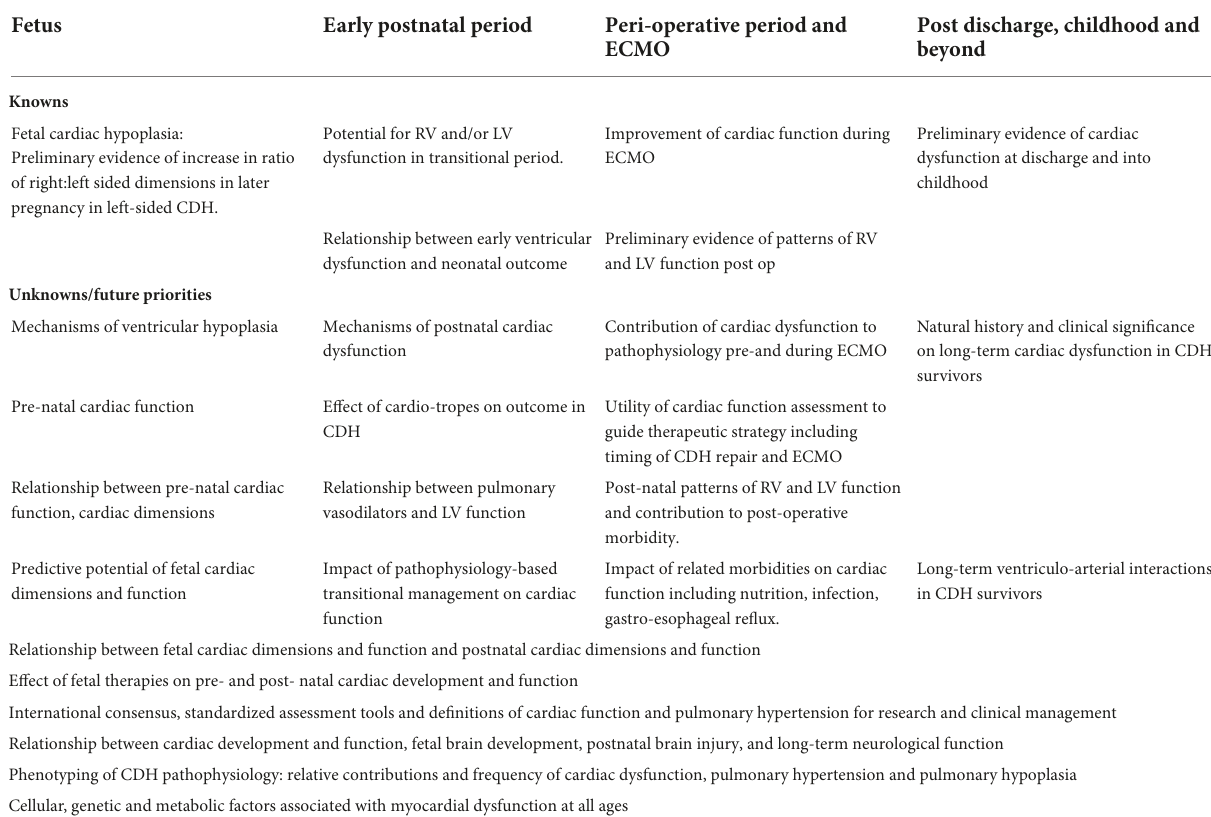
Post discharge, childhood and beyond